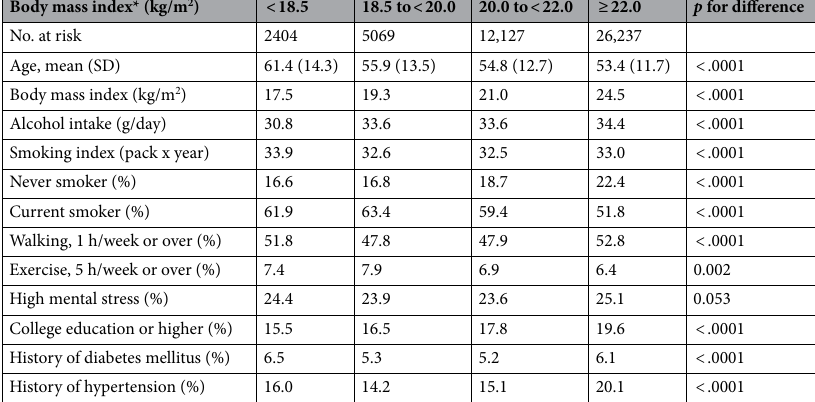
Body mass index (kg /m 2 ) <